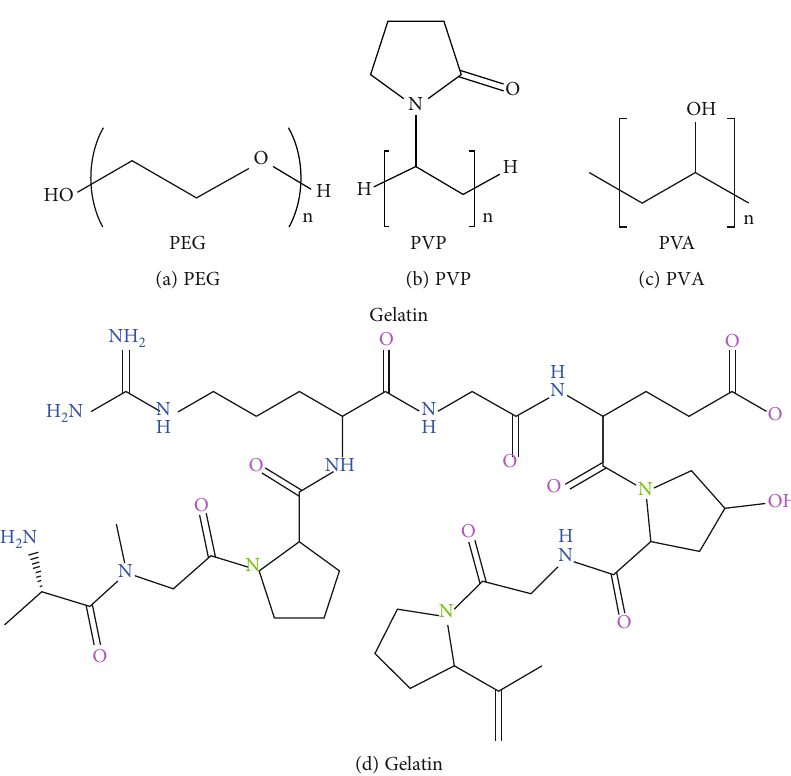
Scheme 2: Chemical structure of the polymeric antiscalants employed in this study for the mitigation of the antimony-rich Table 1: The composition of deposit based on Rietveld method. The